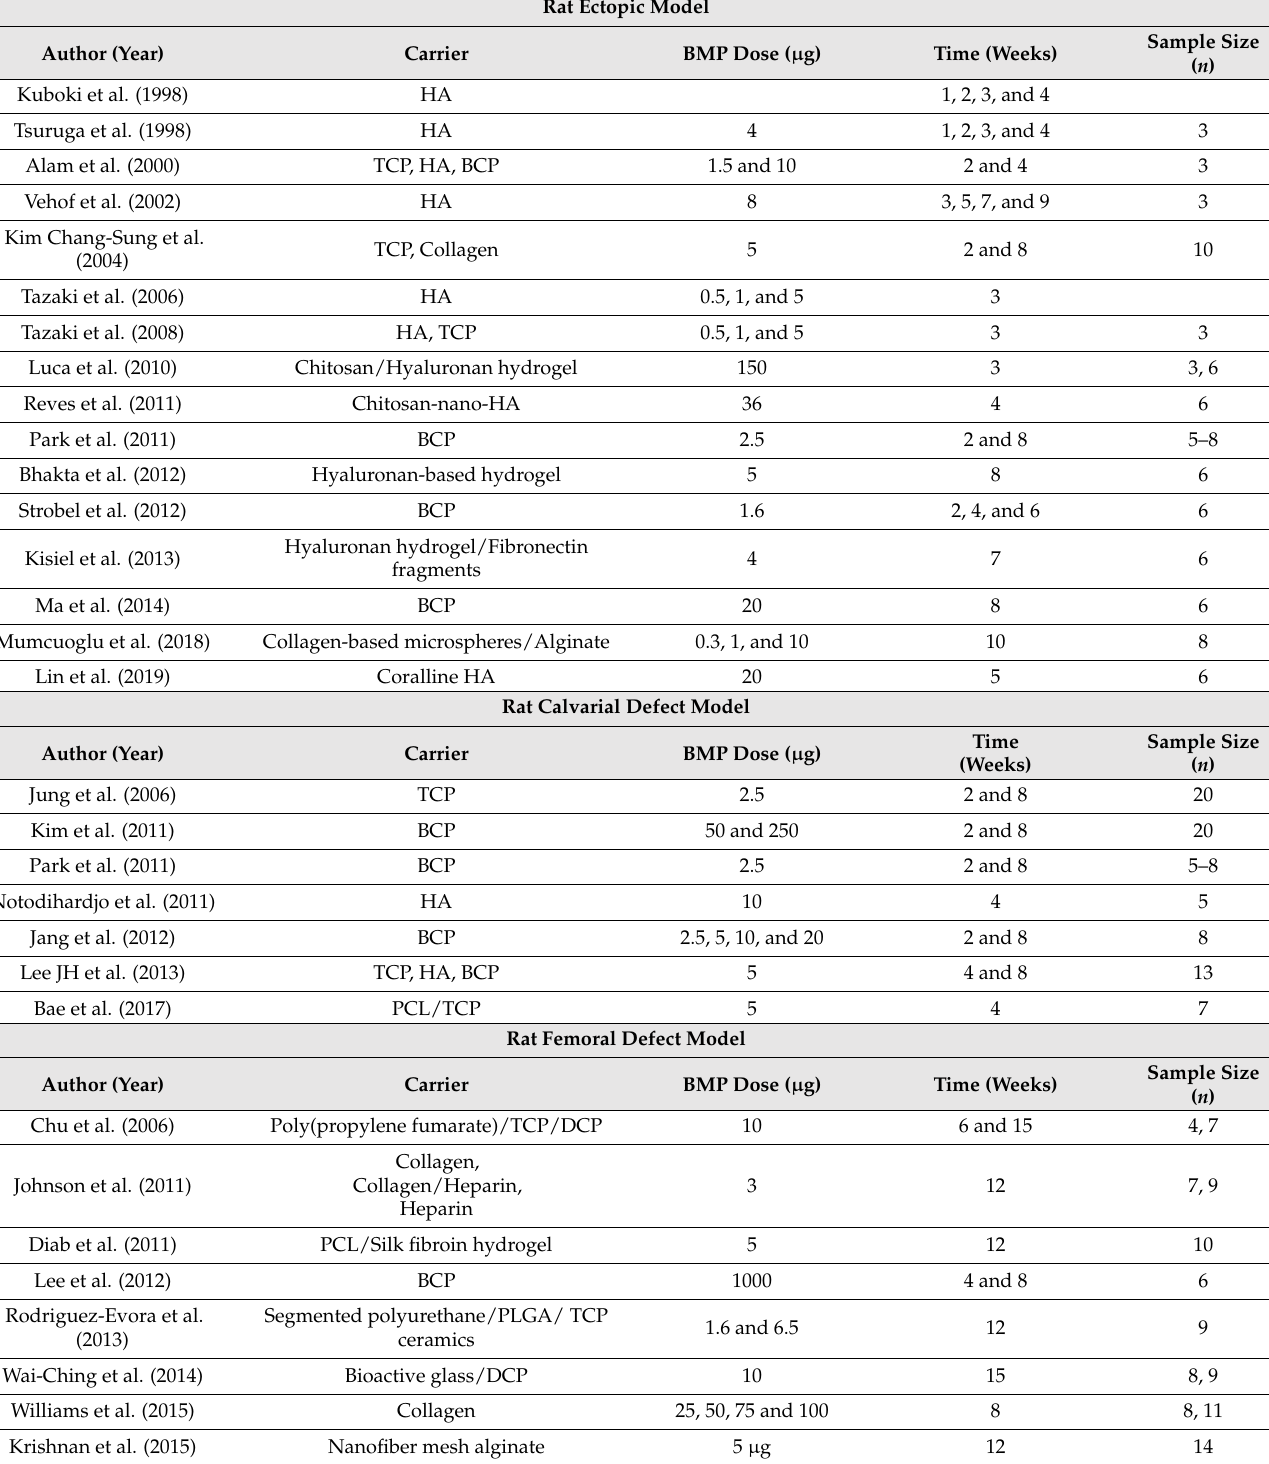
Table 2. Rat ectopic and bone defect